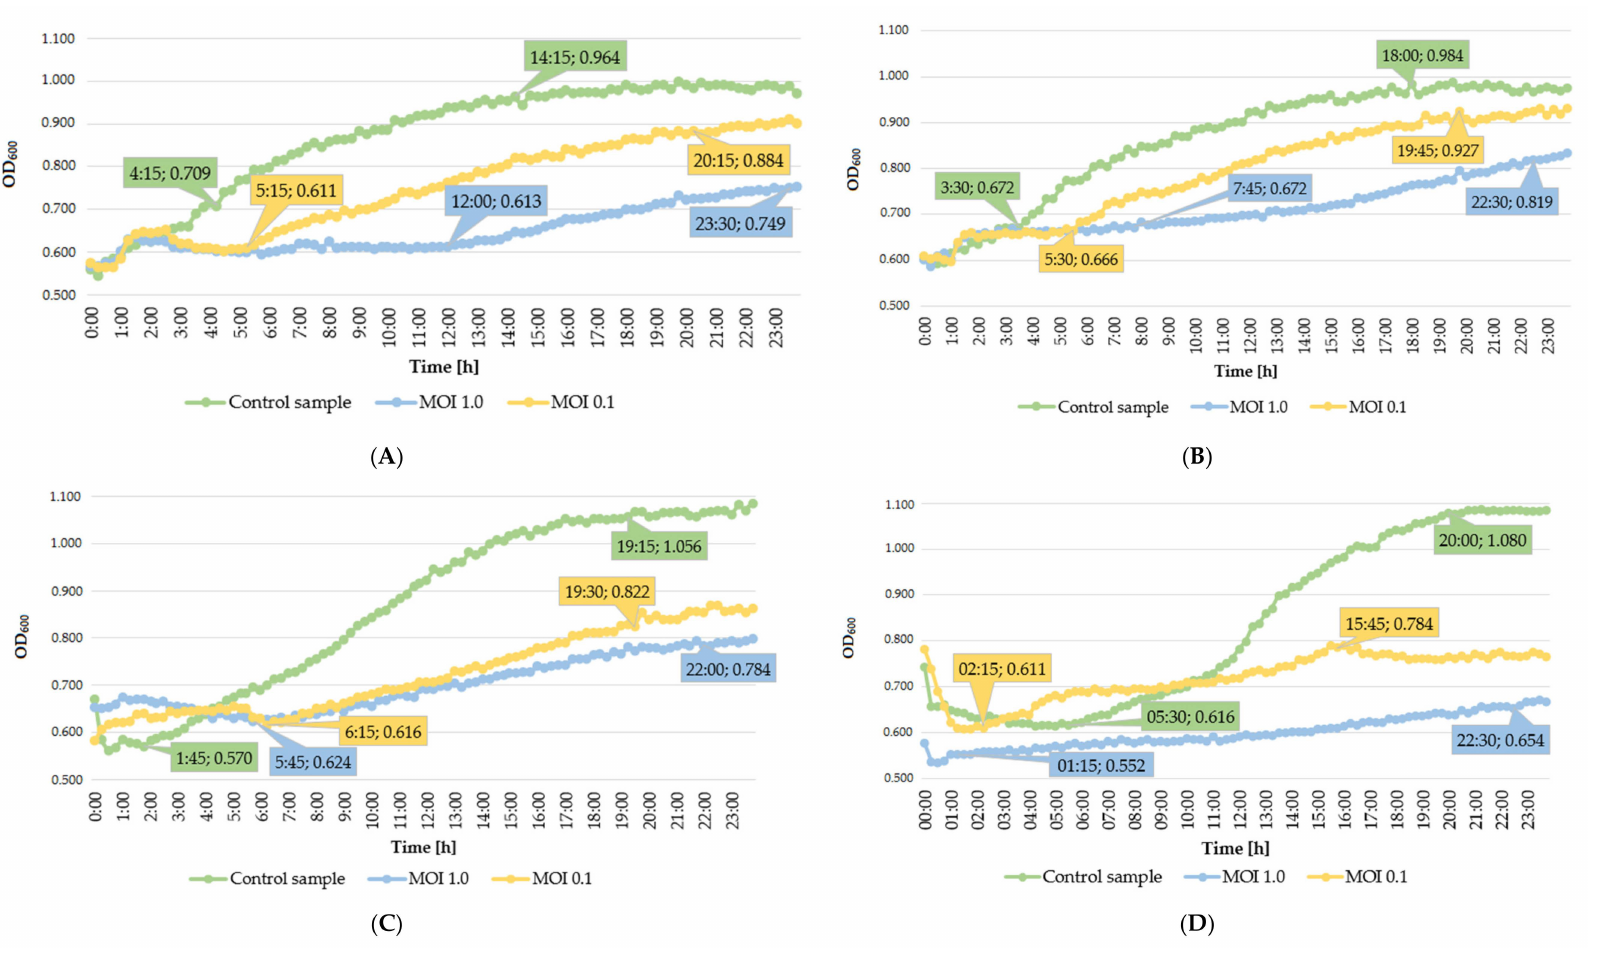
Figure 2. Growth curves of the bacterial strains treated with phages at infection coefficients of MOI 1.0 and MOI 0.1 compared to the control culture: ( A ) Citrobacter freundii KKP